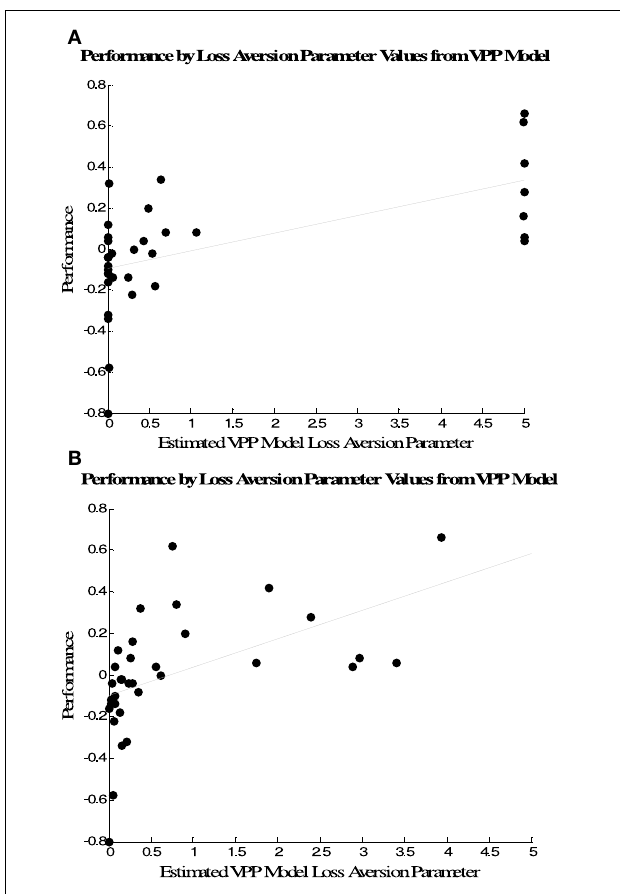
FIGURE 4 | Association between performance and loss aversion parameter estimates from the VPP model when parameters are estimated via (A) maximum likelihood and (B) Bayesian hierarchical estimation.